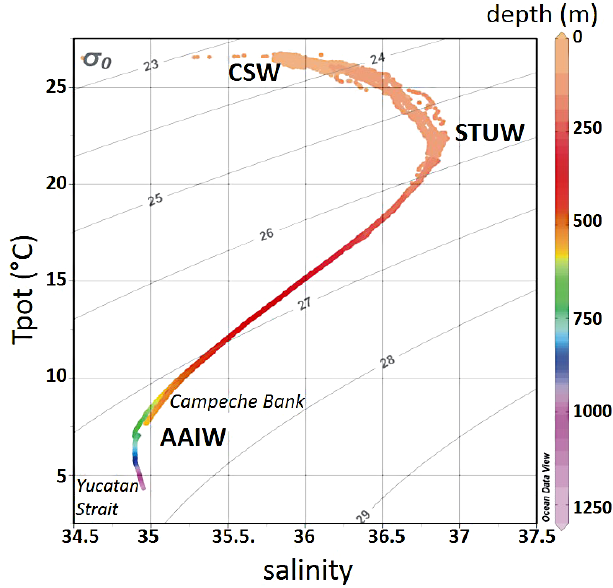
Fig. 5. Water mass structure in the Yucatan Strait (GeoB 16303-1) and in the Campeche cold-water coral province (GeoB 16316-1 to - 16, Yoyo CTD station; see Table 1). Shown is a temperature–salinity plot; temperature is displayed as potential temperature ( T pot ), grey lines indicate levels of isodensity ( σ 2 ) in kgm − 3 (plotted using Ocean Data View v.4.5.1; http://odv.awi.de; Schlitzer, 2012). Ab- breviations: CSW: Caribbean Surface Water; STUW: Subtropical Intermediate Water; AAIW: Antarctic Intermediate